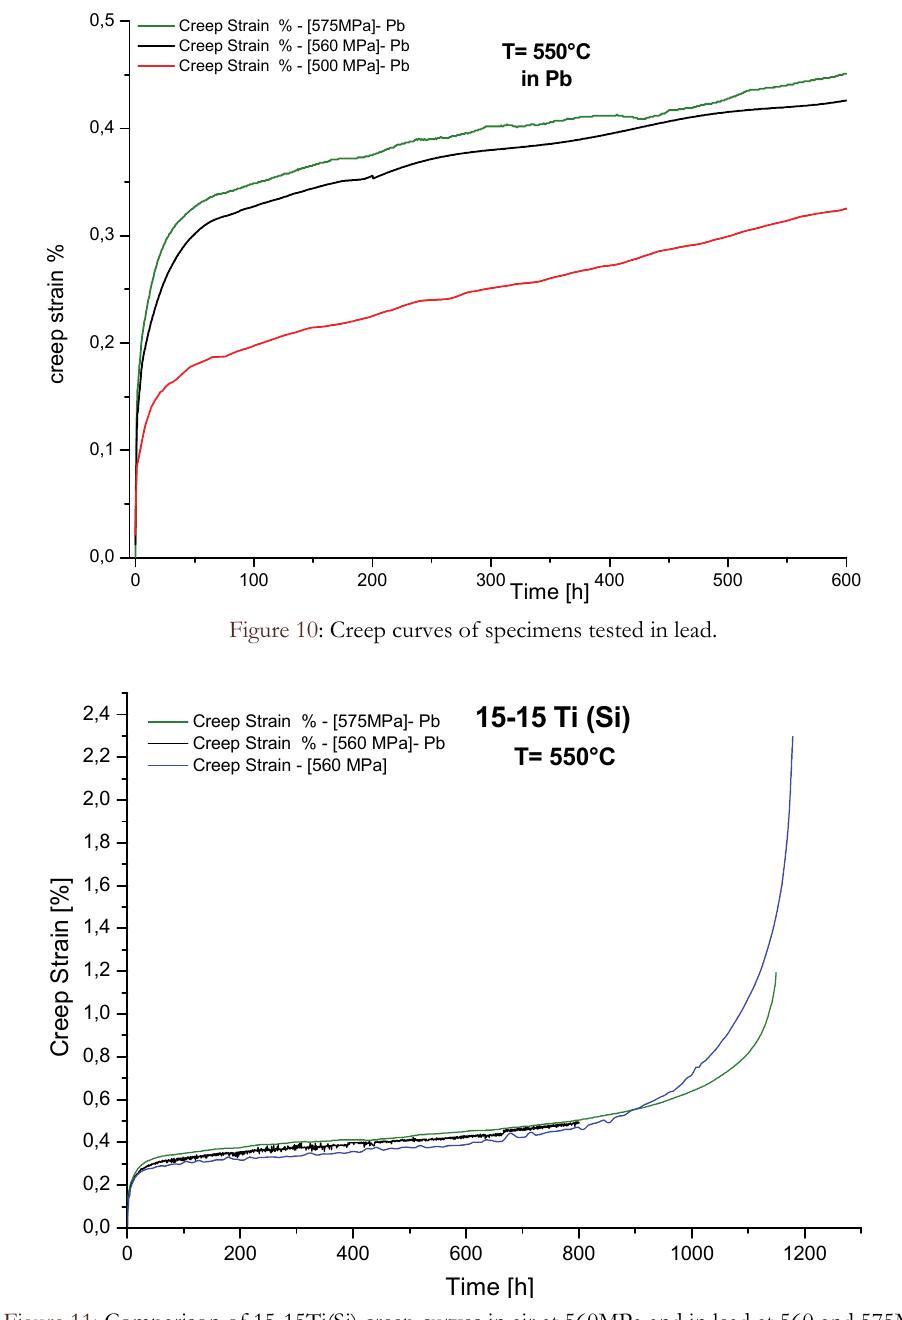
Figure 11: Comparison of 15-15Ti(Si) creep curves in air at 560MPa and in lead at 560 and